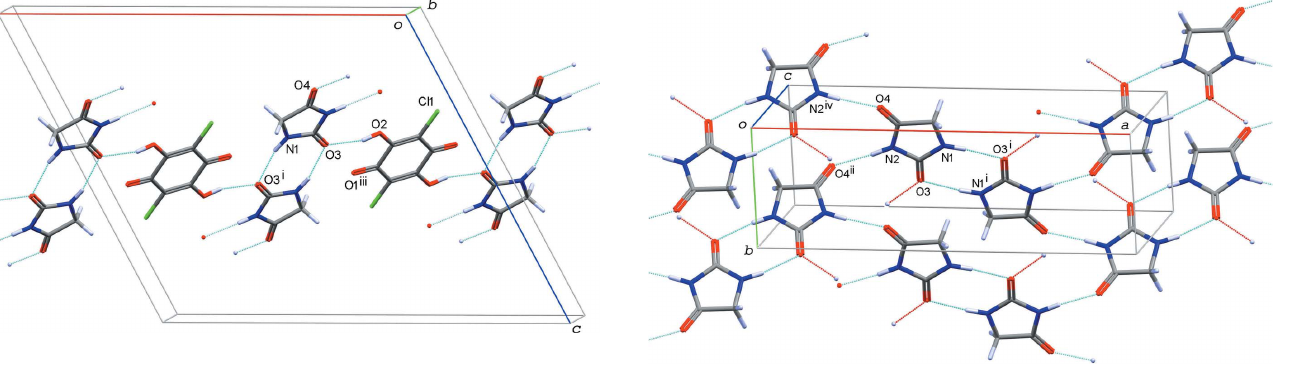
, (cid:4) y + 5 , (cid:4) z + 1.] 2 2